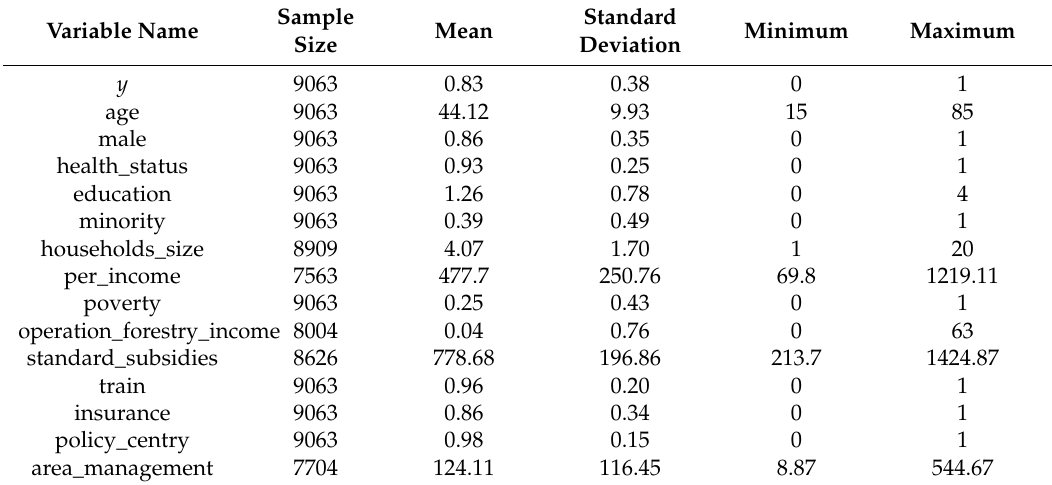
Table 6. Descriptive statistics of main variables.